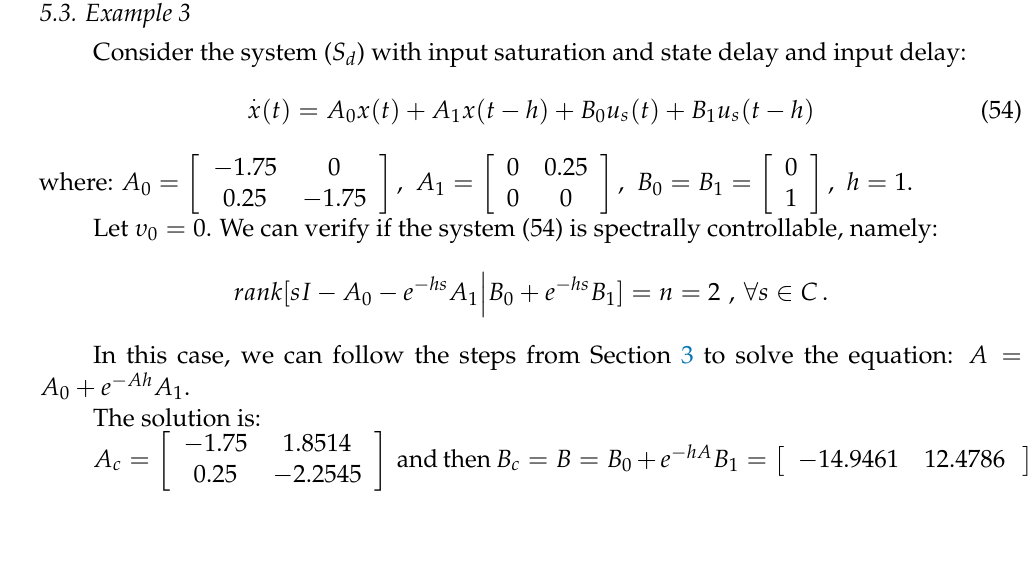
Figure 6. Evolution of the states with 6271.0